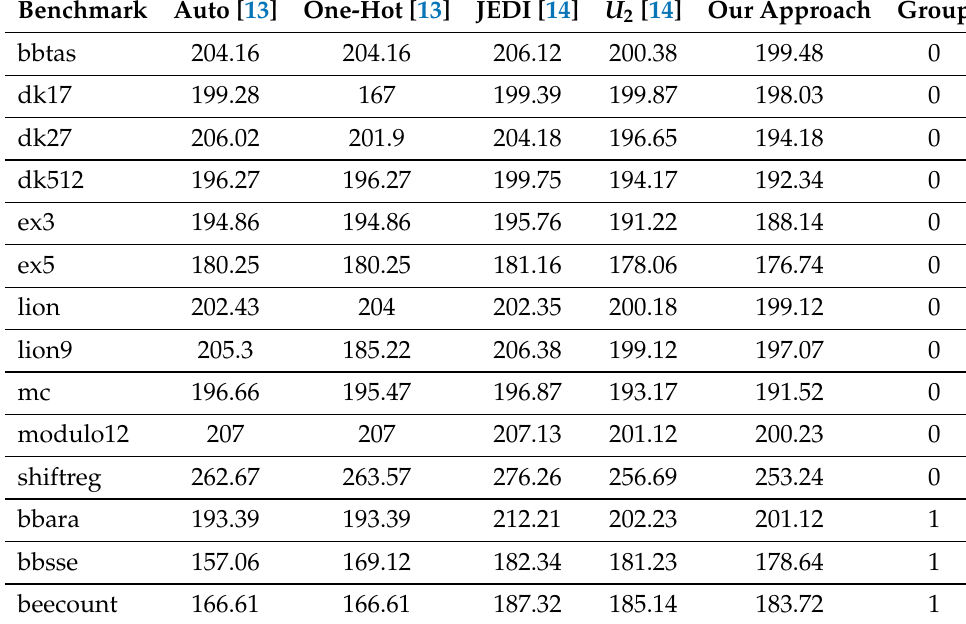
Table 12. Experimental results (the maximum operating frequency for all